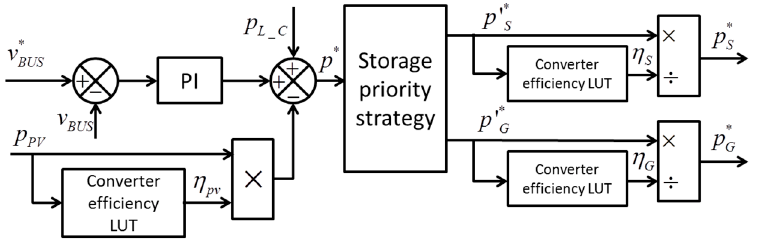
Figure 13. Improved control loop with converter efficiency estimation.